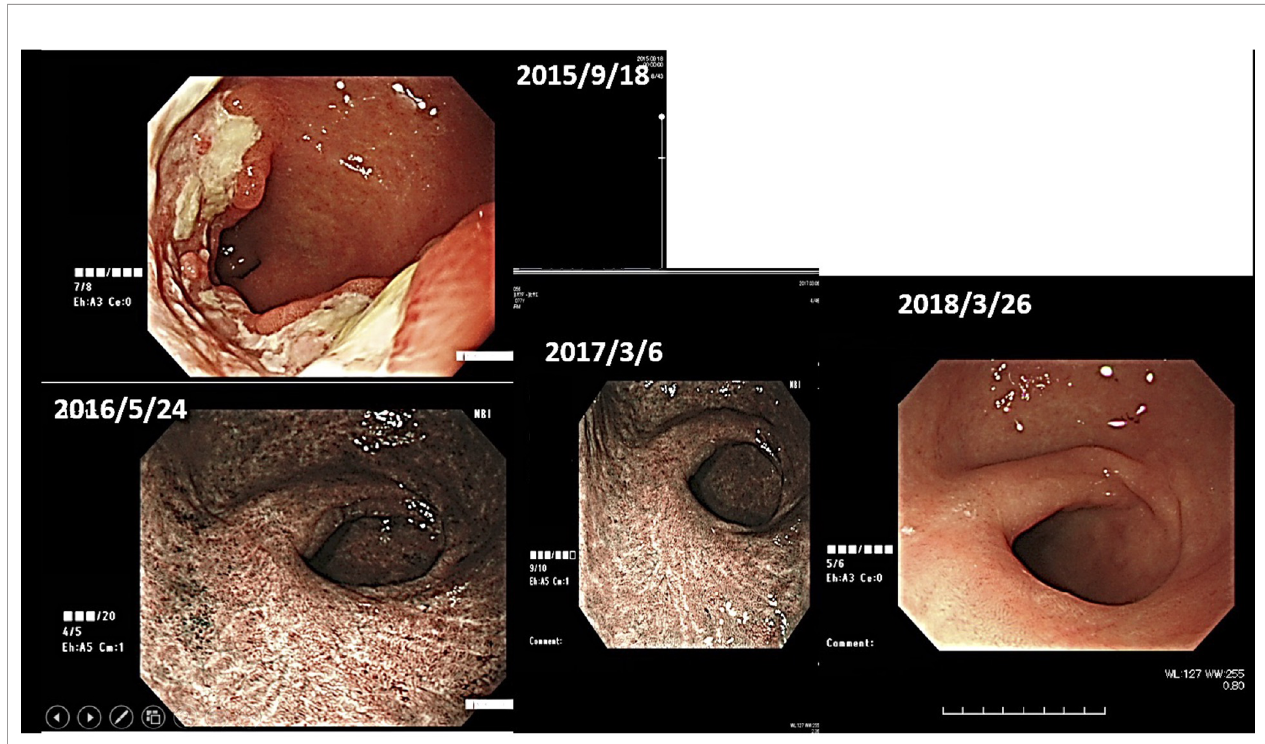
FIGURE 4 | Her images of upper gastrointestinal endoscopy are shown.